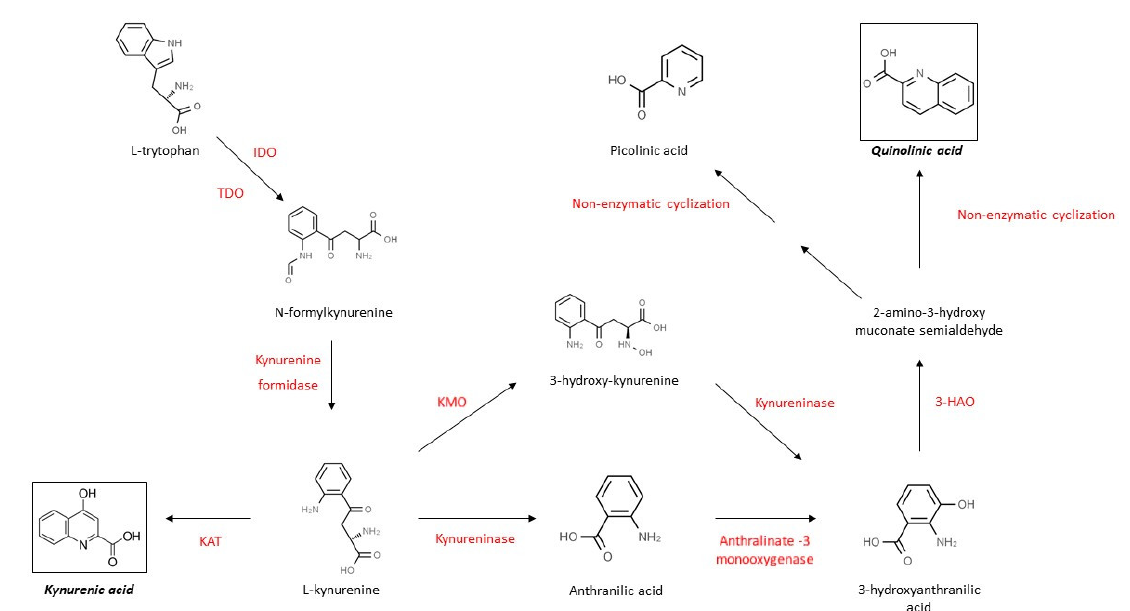
Figure 2. Metabolism of tryptophan: the kynurenine pathway. IDO, indolamine 2,3-dioxygenase; TDO, tryptophan 2,3- dioxygenase; KAT, kynurenine aminotransferase; KMO, kynurenine 3-monooxygenase; 3-HAO, 3-hydroxyanthranilate